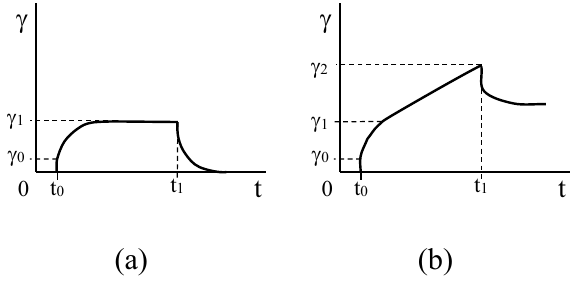
Figure 8: Typical creep curves of strain versus time under constant stress: (a) viscoelastic solid response; (b) viscoelastic liquid re- sponse. The stress is applied at t=t 0 and removed at t=t 1 . Modified from [15, 16] neously (0 to 𝛾 ), then the deformation continuously in- 0 creases along time ( 𝛾 to 𝛾 ); when the stress is removed 0 2 (t ), the deformation is partially restored; only the elastic 1 deformation is